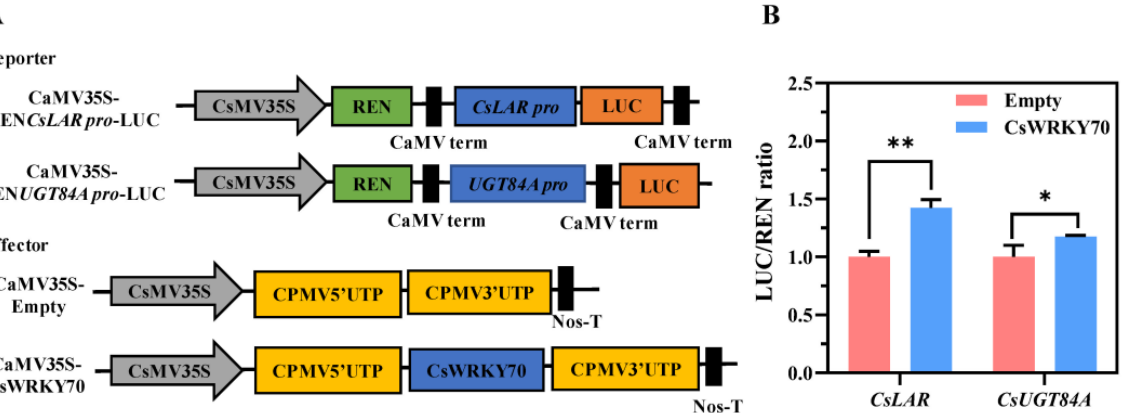
Figure 6. The ability of CsWRKY70 to activate transcription of CsLAR and CsUGT84A promoters in tobacco leaves ( Nicotiana benthamiana ). ( A ) Schematic diagram of vector plasmids. ( B ) CsWRKY70 activates the promoter activities of CsLAR and CsUGT84A . * and ** represent significant differences ( p < 0.05 and p < 0.01, respectively) compared to the empty control. Data were analyzed by Student’s t -tests.